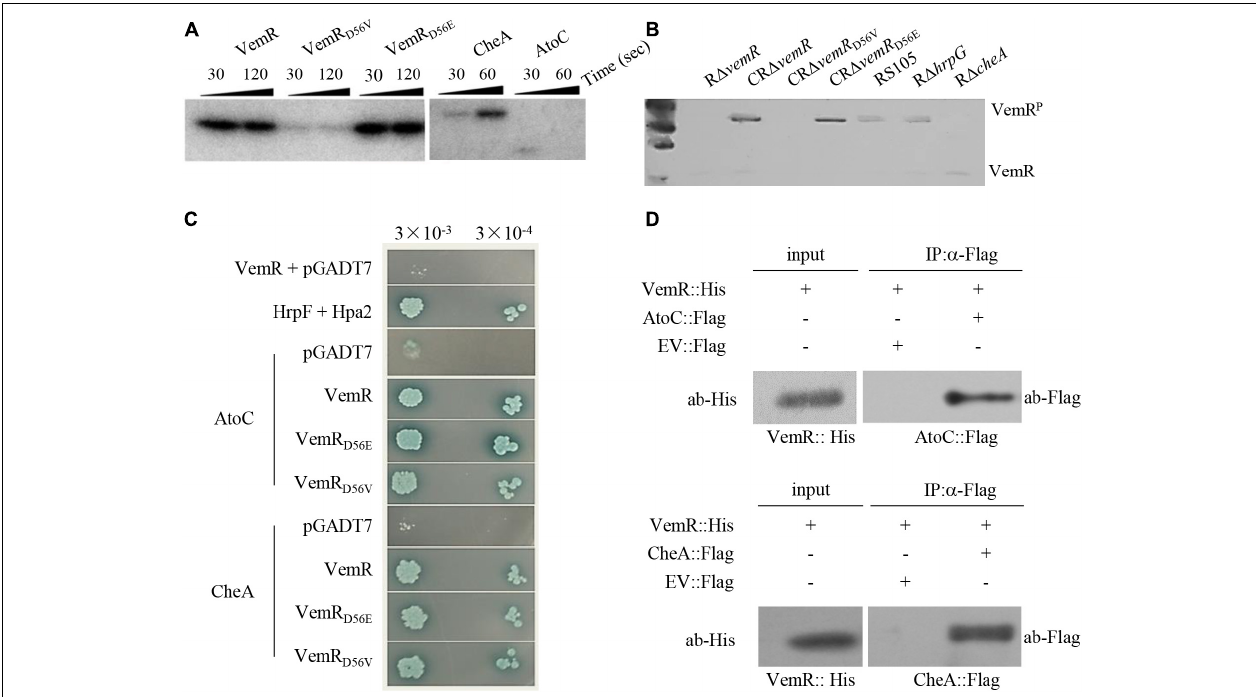
FIGURE 4 | Sensor kinase CheA phosphorylates VemR in X. oryzae pv. oryzicola ( Xoc ). (A) In vitro phosphorylation assay showing phosphorylation of VemR (at D 56 residue) and CheA. Purified VemR, VemR D 56 E , VemR D 56 V , CheA, and AtoC proteins (10 µ M) were incubated with 100 µ M [ γ − 32 P]ATP (10 µ Ci) and 10 µ M histidine kinase. The reactions were stopped at the indicated time points by loading buffer prior to separation by SDS-PAGE and autoradiography. (B) In vivo assay showing phosphorylation of VemR. Xoc strains expressing 6 × His tagged VemR proteins were cultured in MMX medium for 36 h. Total proteins from the cultures were extracted and resolved on Phos-tag acrylamide-copolymerized SDS-PAGE gel. Recombinant VemR proteins were detected using anti-VemR antiserum. (C) Interactions of VemR with CheA and AtoC were confirmed by yeast two-hybrid and β -gal assays. Yeast Y2H Gold cells (strain AH109) were co-transformed with the “bait” pGBKT7 and the “prey” pGADT7 derivative vectors expressing VemR fused with the GAL4 DNA binding domain (BD) and CheA or AtoC proteins fused with the GAL4 activation domain (AD), respectively. Serial dilutions of the selected co-transformants were plated on QDO (Quadruple dropout; SD/-Leu/-Trp/-Ade/-His) plates with and without X- α -Gal and incubated at 28 ◦ C for 3 days. Co-expression of pB- hpa2 /pA- hrpF and pB- vemR /pGADT7 represent positive and negative controls, respectively. (D) Co-immunoprecipitation analysis showing VemR interactions with AtoC (upper panel) and CheA (lower panel). Samples before (input) and after (IP: α -His) immunopurification were analyzed by immunoblotting using anti-Flag and anti-His